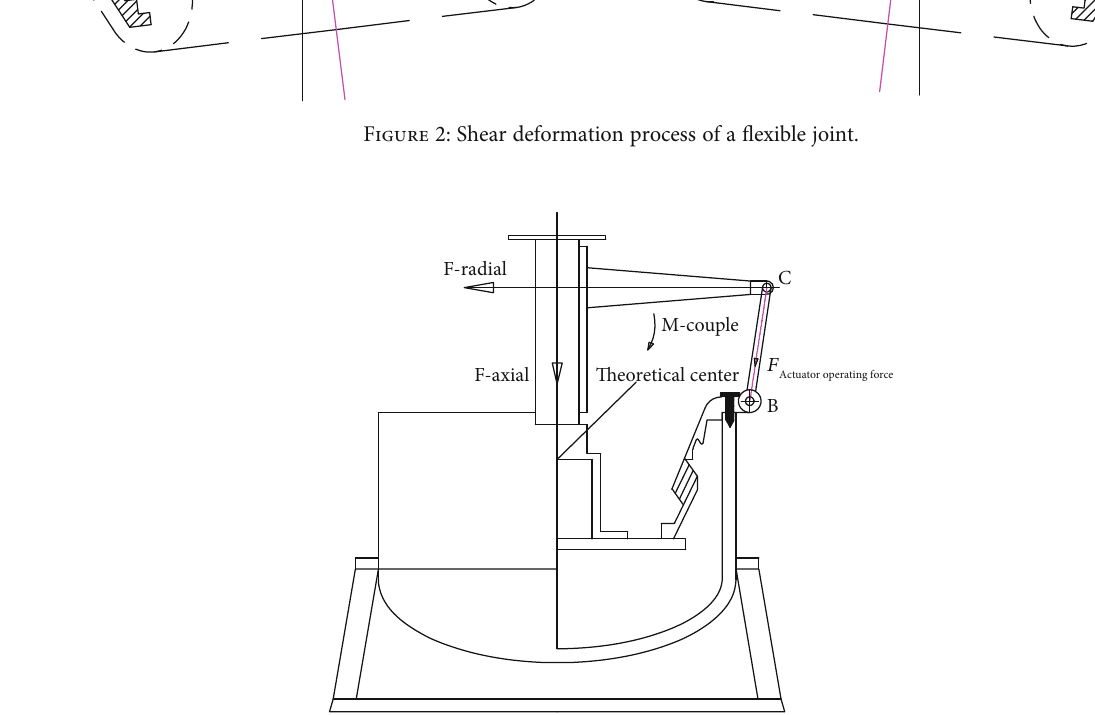
Figure 3: The swing test diagram of fl exible joint.